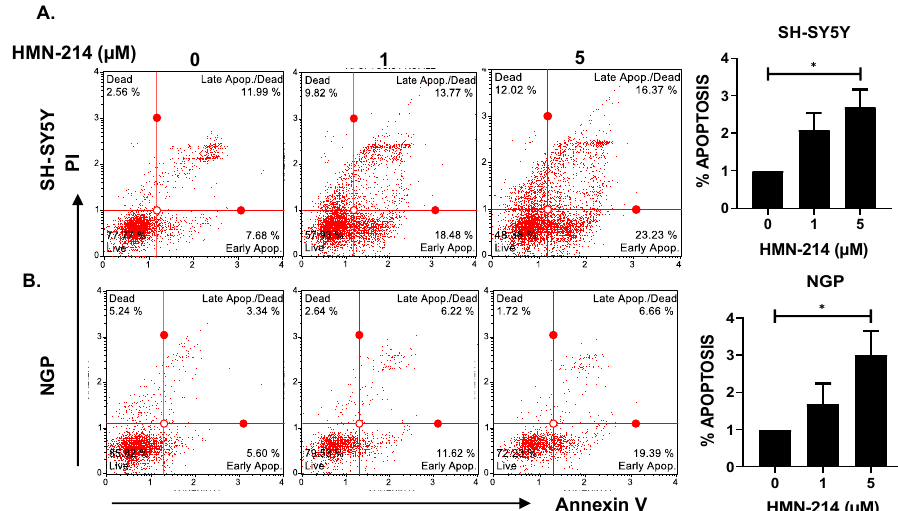
Figure 4. HMN-214 induces apoptosis in NB. Apoptosis assays performed in response to HMN-214 treatment in both MYCN-non-amplified (SH-SY5Y) and MYCN-amplified (NGP) cell line. ( A , B ) Representative flow cytometer images and quantitative representation of percentage of early apoptosis. ( A ) SH-SY5Y, ( B ) NGP. * p < 0.05.